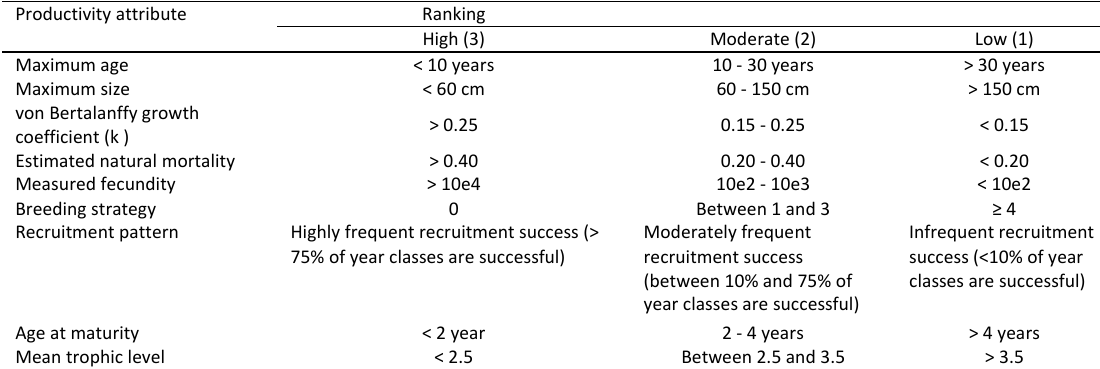
Table 1: Productivity attributes and